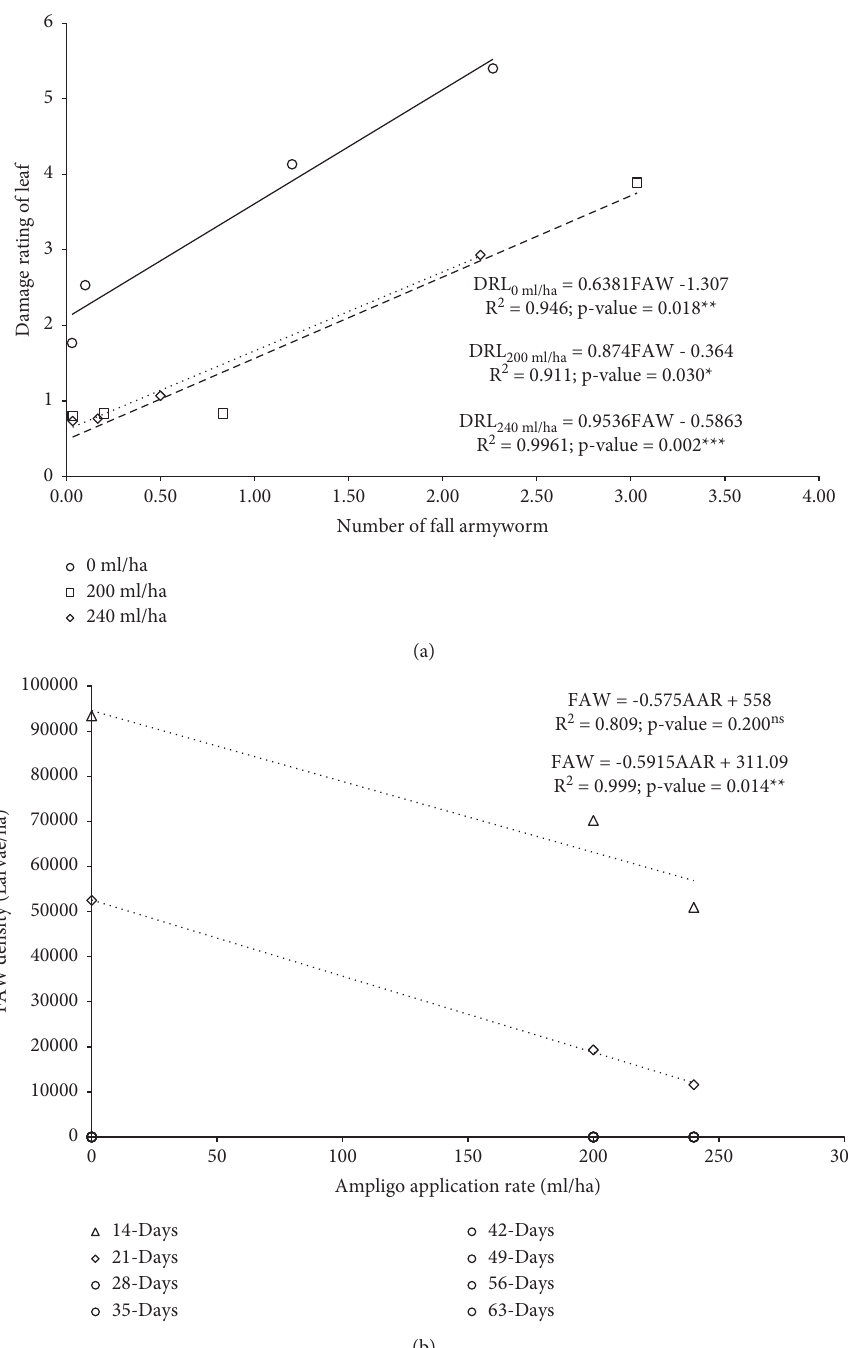
Figure 2: Relationship between fall armyworm density and (a) damage rating of leaf and (b) Ampligo application rates used for controlling armyworm infestation on maize at different growth